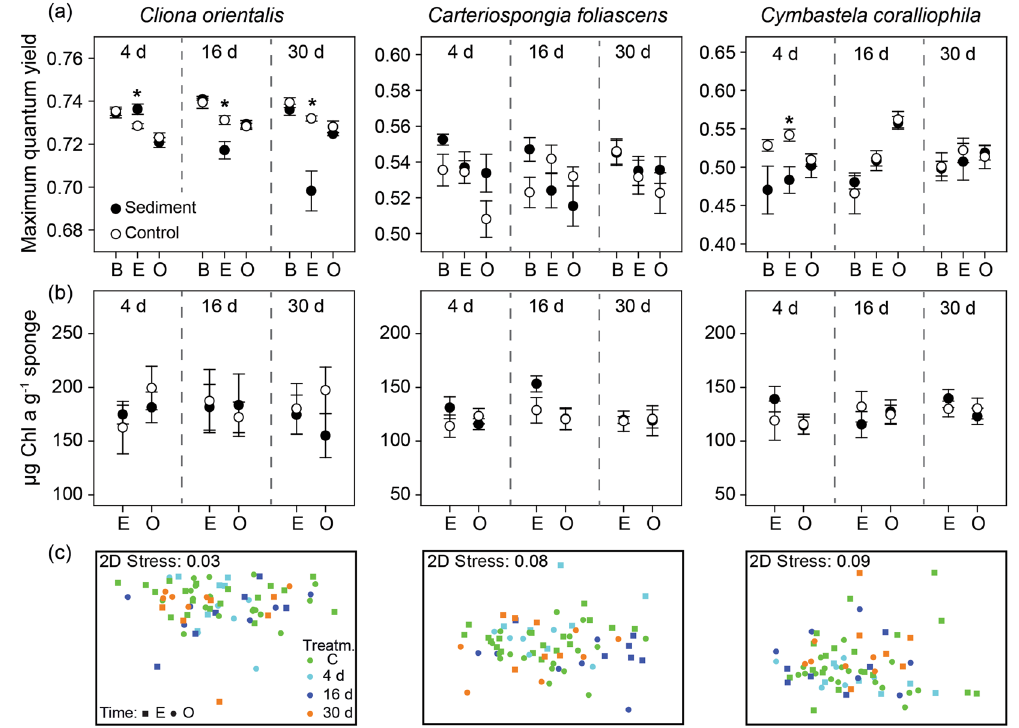
Figure 4. Responses of photosymbionts to smothering treatments. ( a ) Mean values ( ± SE) of maximum quantum yield, ( b ) Mean values ( ± SE) of Chl a, and ( c ) Non-metric Multi-Dimensional Scaling (nMDS) of all photopigments retrieved by spectrophotometry, for the 3 phototrophic species and for all smothering treatments (4, 16 and 30 d smothered vs. controls), before exposure ( b ) and through the experimental ( E ) and observational periods ( O ). Asterisks show statistically significant differences between controls and smothered samples (Table 2) (t-tests: P <